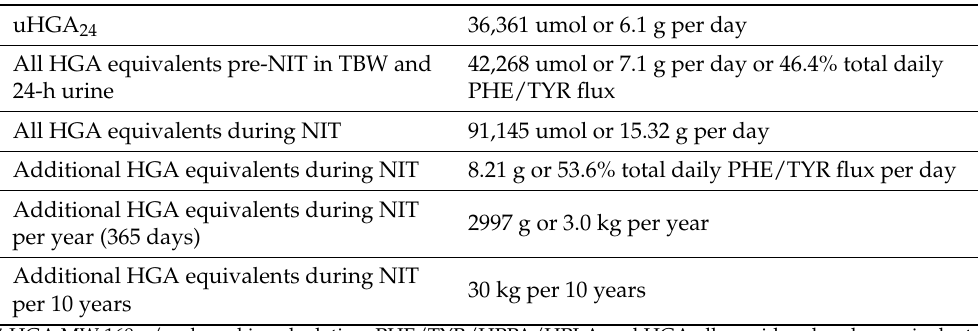
Table 2. Estimates of HGA * equivalents generated pre- and peri-nitisinone to calculate burden of accumulating HGA over time. uHGA 24 36,361 umol or 6.1 g per